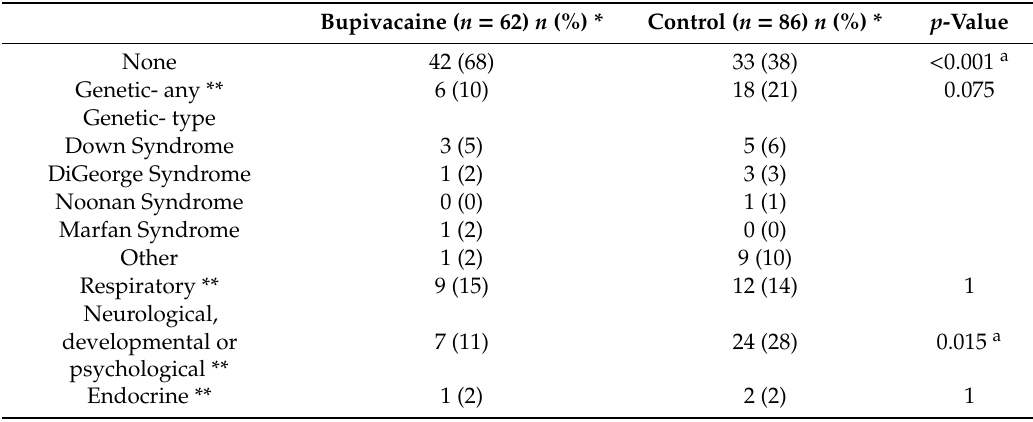
Table 3. Patient clinical information